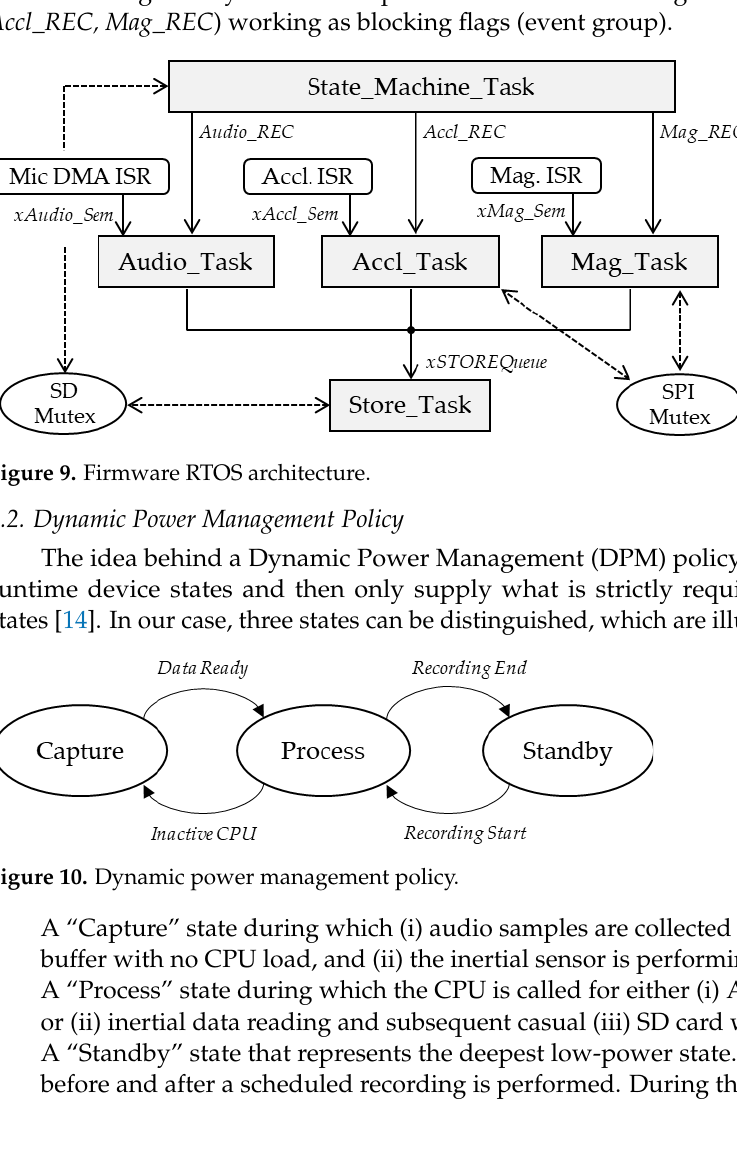
Figure 9. Firmware RTOS architecture.